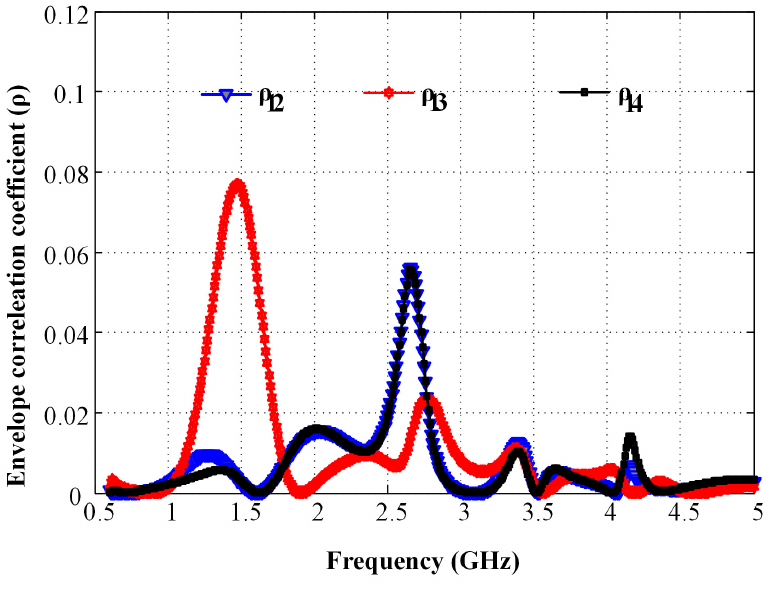
Figure 8. Measured performance for the envelope correlation coefficient